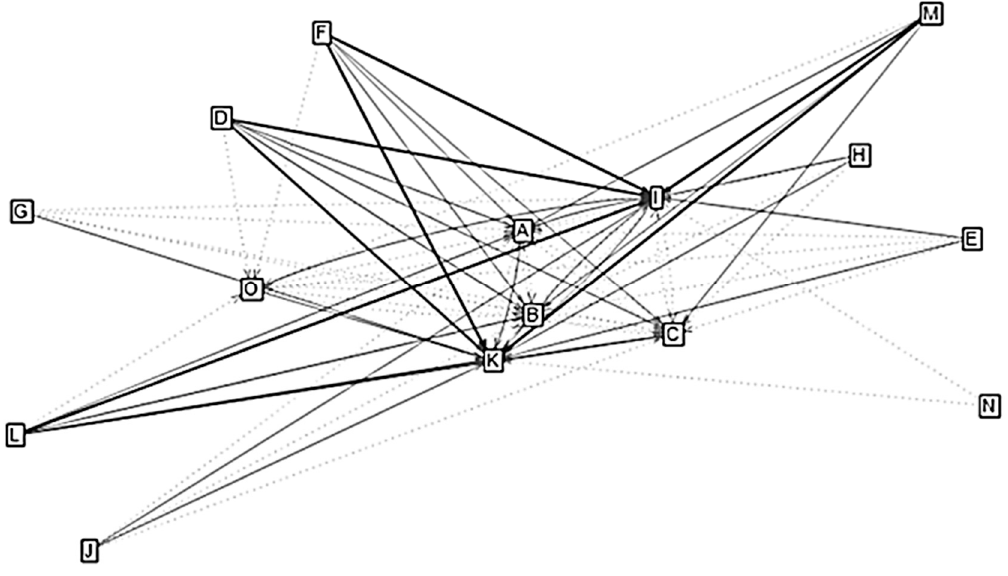
Figure 8. Indirect impact graph.